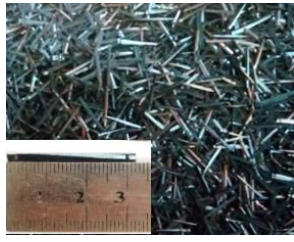
Figure 2. The particle size distribution of the aggregates.